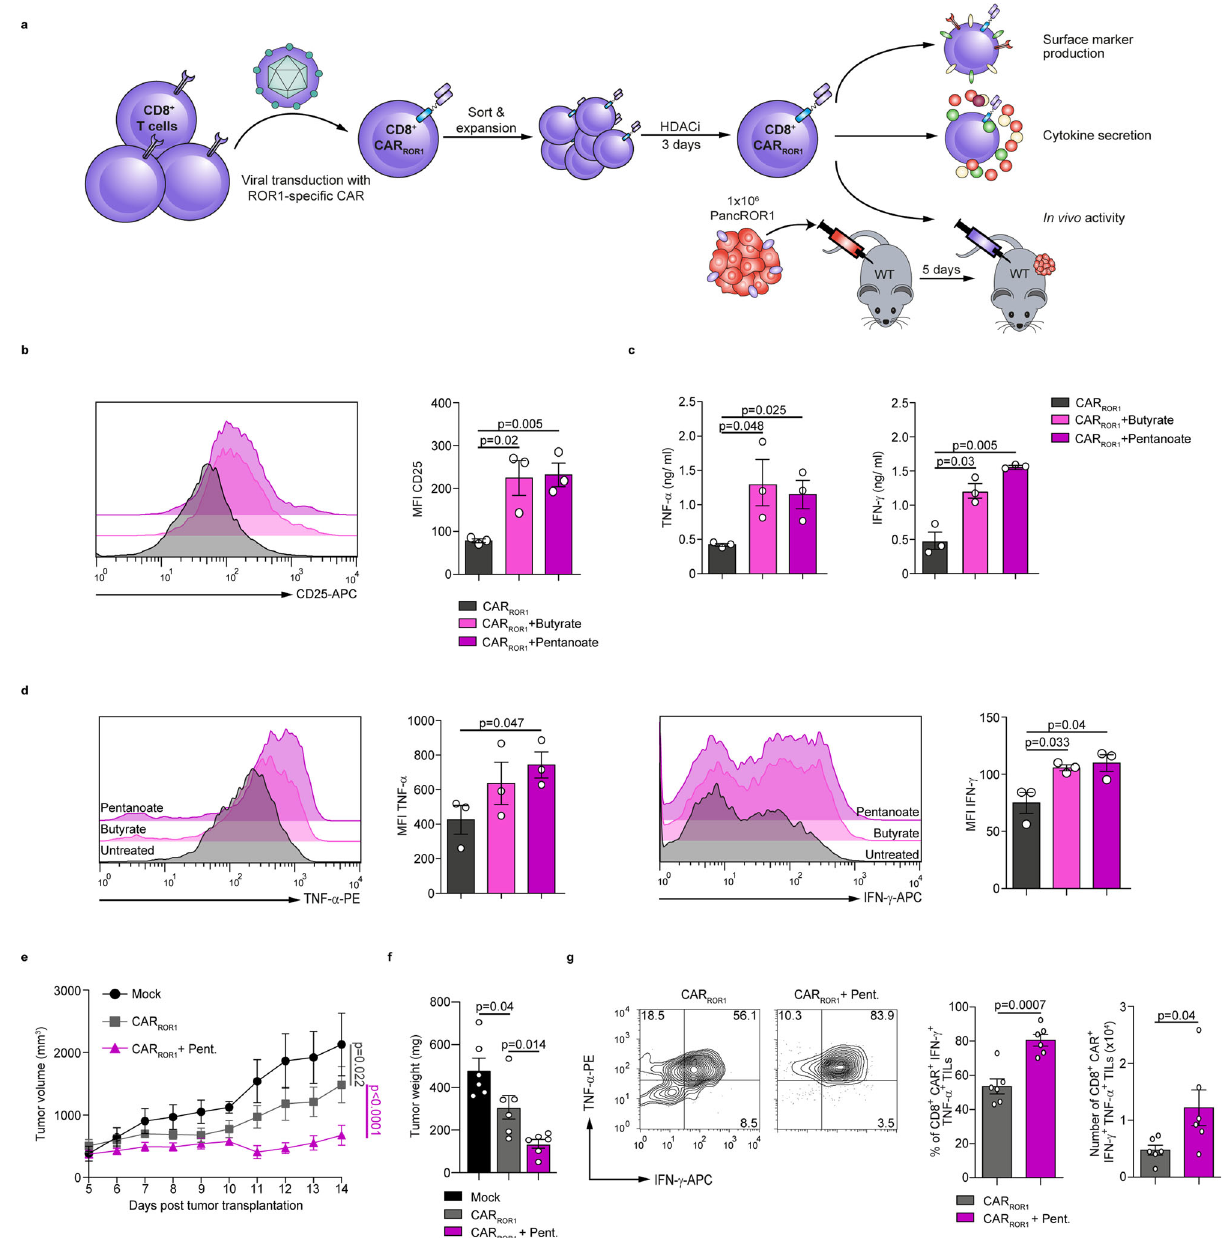
Fig. 4 Pentanoate-treatment enhances the anti-tumor activity of murine CAR T cells. a Experimental design for the analysis of SCFA-treated ROR1- speci fi c murine CD8 + CAR T cells (CAR ROR1 ). b The surface expression of CD25 on CAR T cells was measured by fl ow cytometry analysis after three days of stimulation with butyrate or pentanoate ( n = 3 independent experiments). c , d The production of TNF- α and IFN- γ from CAR T cells was measured by ELISA ( c ) and fl ow cytometry analysis ( d ) after three days of stimulation with butyrate or pentanoate. Three similar experiments were performed. e – g Following the pretreatment with pentanoate for three days, ROR1-speci fi c CAR T cells were transferred i.p. into mice bearing 5-days old PancROR1 tumors. Tumor volume ( e ) and tumor mass ( f ) were analyzed on day 14 post tumor inoculation ( n = 6 mice/group combined from two independent experiments). The percentage and total cell number of transferred TNF- α + and IFN- γ + CAR T cells in the tumor tissue at day 14 after tumor inoculation are shown in ( g ). For all experiments, 0.75 mM butyrate and 2.5 mM pentanoate were used, respectively. Multiple group comparison in ( e ) was performed by a